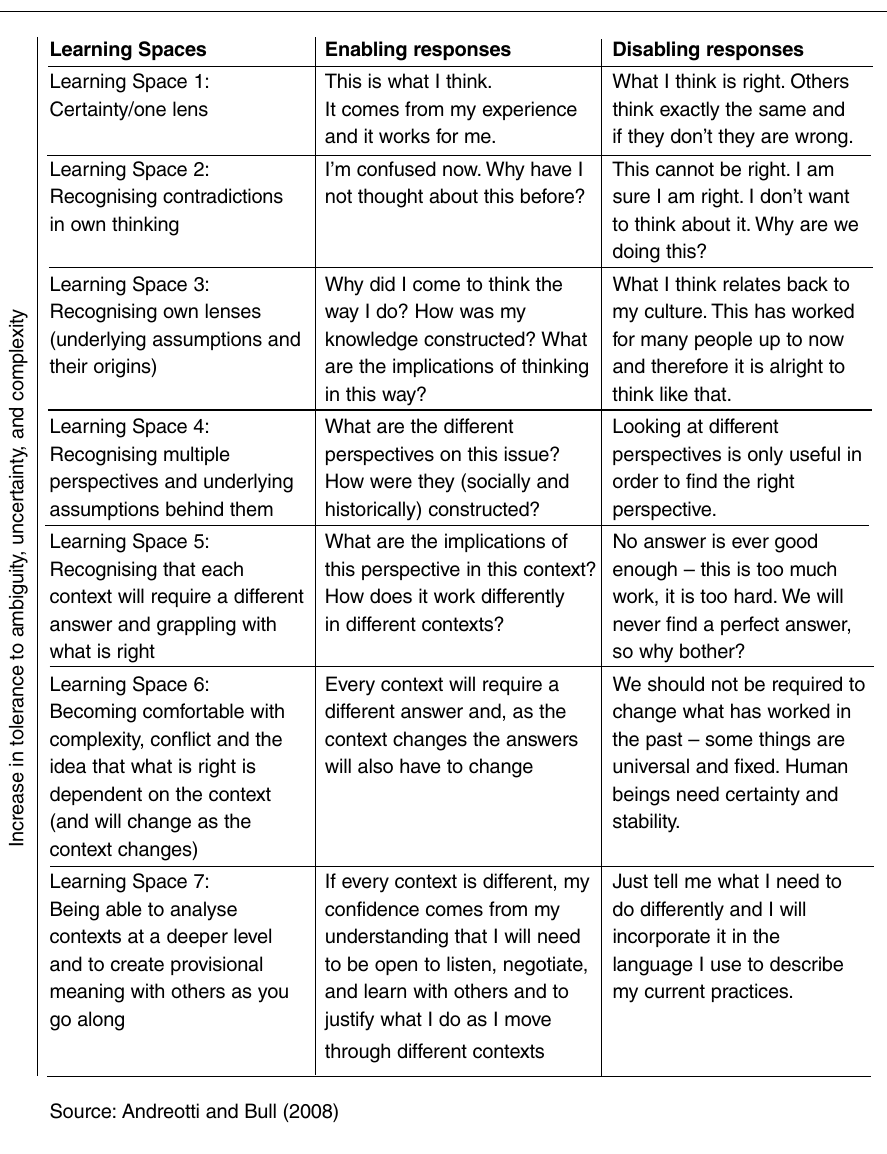
Table 1: NZCER Thinking Together Project – Draft Analysis Model of Participant Responses to a Deconstructive